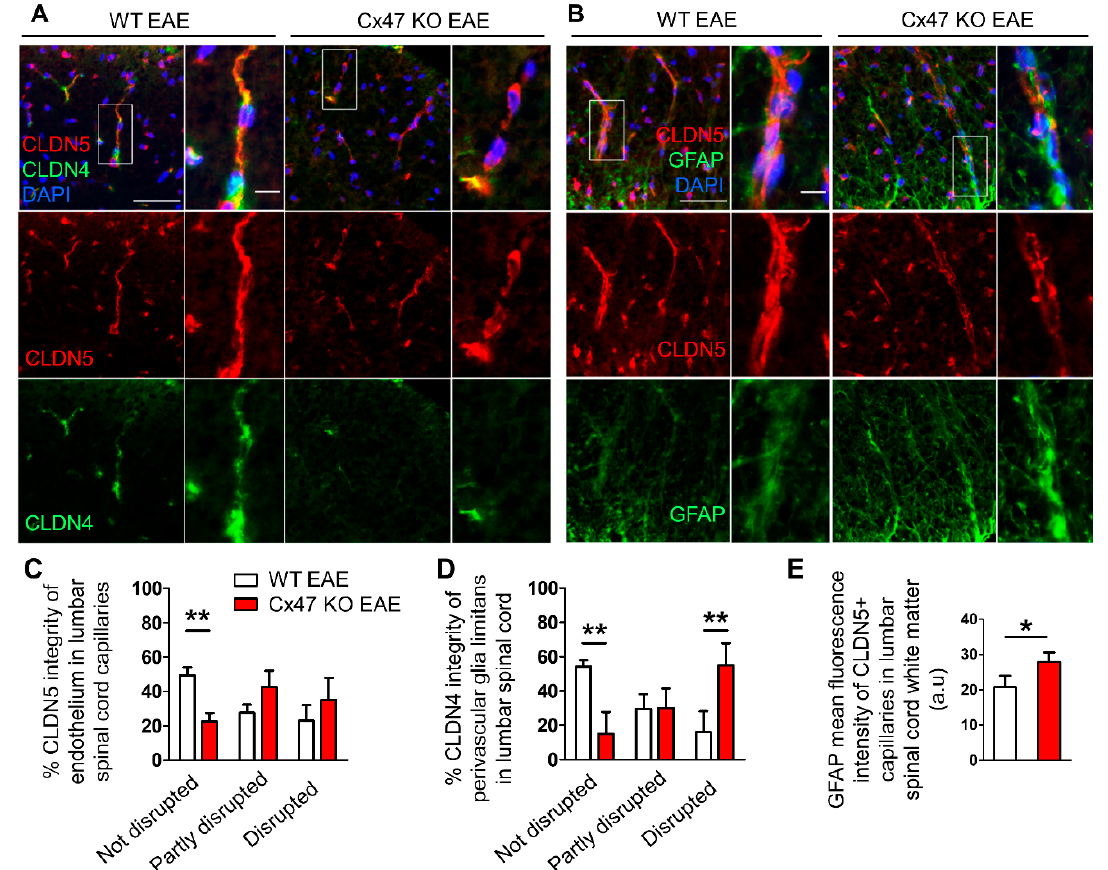
Figure 6. Increased disruption of endothelial and astrocytic tight junctions and increased reactivity of perivascular glia limitans in the lumbar spinal cord of 7 dpi Cx47 KO EAE mice. ( A , B ) Representative immunofluorescence images of lumbar spinal cord cross sections from 7 dpi WT EAE and Cx47 KO EAE mice as indicated (both with a clinical score of 0), stained with antibodies against the endothelial tight junction (TJ) protein CLDN5 (red) and the astrocytic TJ protein CLDN4 (green) in A , or against CLDN5 (red) and the astrocytic marker GFAP (green) in B . Nuclei are counterstained with DAPI (blue). Separate channels and overlays are shown. Magnified views from rectangular boxes are depicted on the right (Scale bars: in overviews 50 μ m, in insets: 10 μ m). Magnified view from WT EAE mouse ( A ) depicts a vessel with an intact CLDN5 and CLDN4 pattern, while a vessel from Cx47 KO EAE ( A ) shows a partly disrupted CLDN5 and a completely disrupted CLDN4 pattern. ( C , D ) Semi-quantitative scoring of endothelial CLDN5 ( C ) and of perivascular CLDN4 ( D ) staining pattern in lumbar spinal cord capillaries of WT EAE ( n = 3) and Cx47 KO EAE ( n = 4) mice. Data are presented as mean ± SD. Two-way ANOVA with post hoc Bonferroni test: ** p < 0.01. ( E ) Semi-quantitative analysis of GFAP fluorescence intensity, overlapping with vessel-like CLDN5 fluorescence pattern ( n = 10 vessels/mouse), using ImageJ from the lumbar spinal cord white matter of n = 4 WT EAE mice and n = 4 Cx47 KO EAE mice (clinical score of all mice was 0). a.u., arbitrary units. Data are presented as mean ± SD. Unpaired student’s t -test: * p < 0.05.